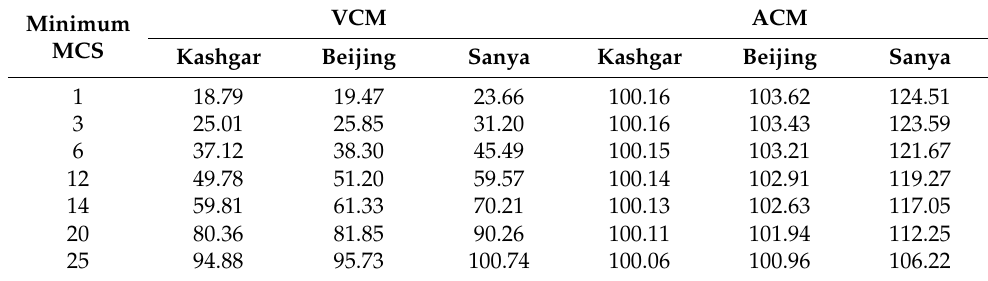
Table 9. The TEF ratio of ACM or VCM relative to CCM of MCS 28